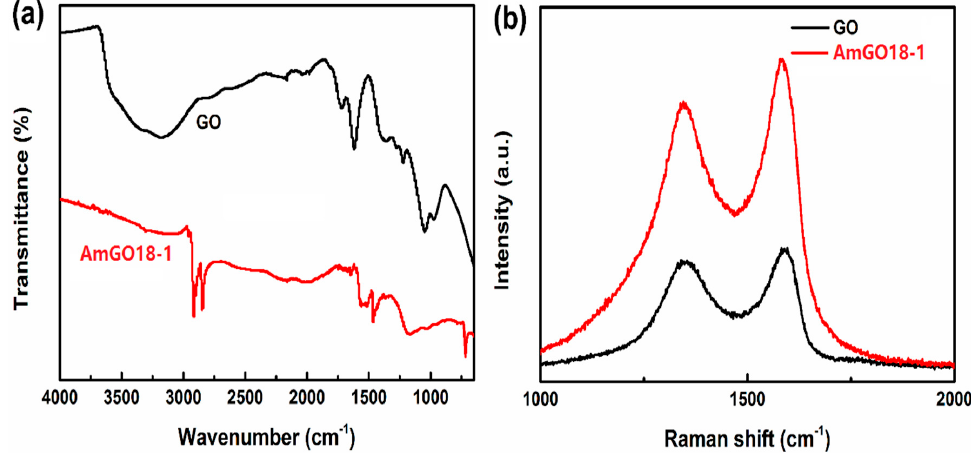
Figure 1. ( a ) FTIR spectra of GO and AmGO18-1; ( b ) Raman spectra of GO and AmGO18-1.